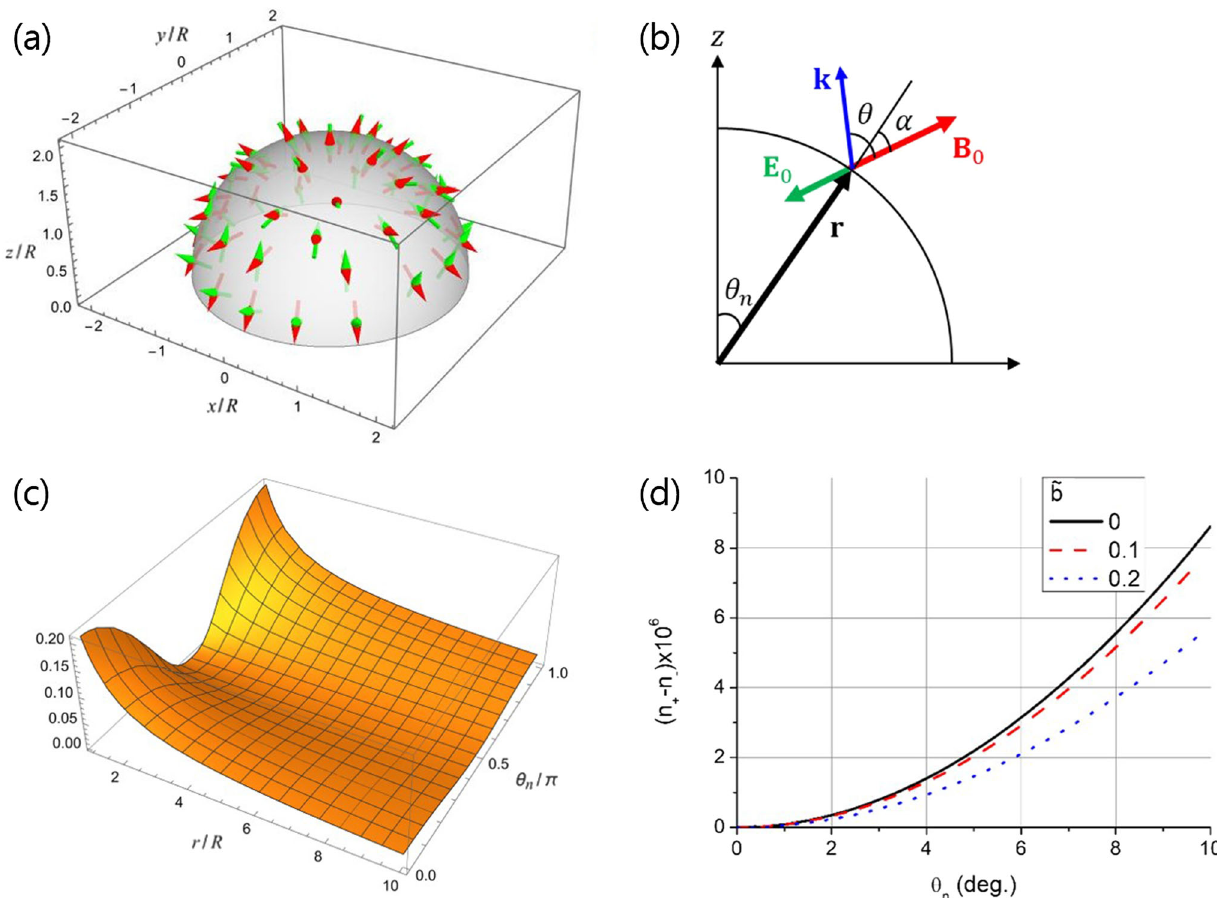
Fig. 9 Vacuum birefringence in pulsar magnetosphere. a The direc- tions of the magnetic (red arrow) and electric (green arrow) fields, b the configuration of the background fields and the photon propagation vector near the north pole ( θ < 25 ◦ ), c the distribution of ˜ b = b / a for a pulsar with (cid:20) = 2 π/( 1 ms ) and R = 10 km, and d the difference of the